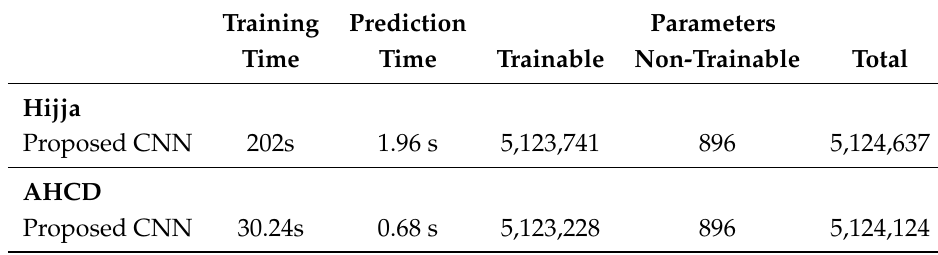
Table 6. Computational